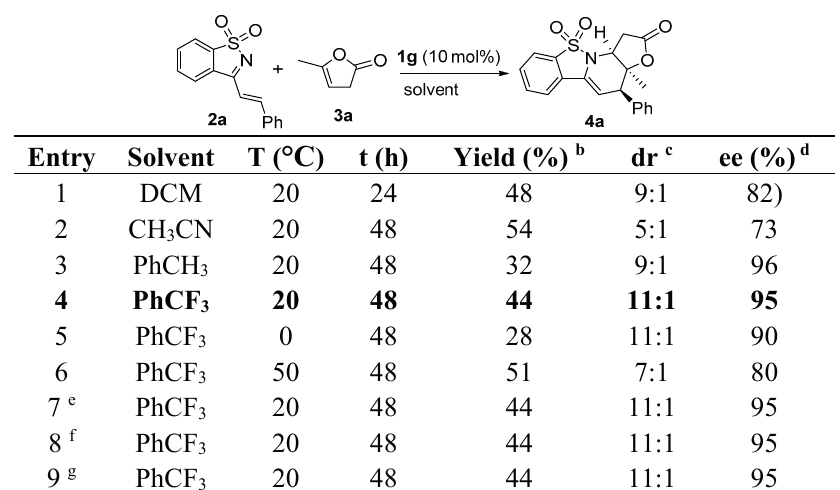
Table 2. Reaction condition screenings catalyzed by (DHQD) 2 PHAL 1g a